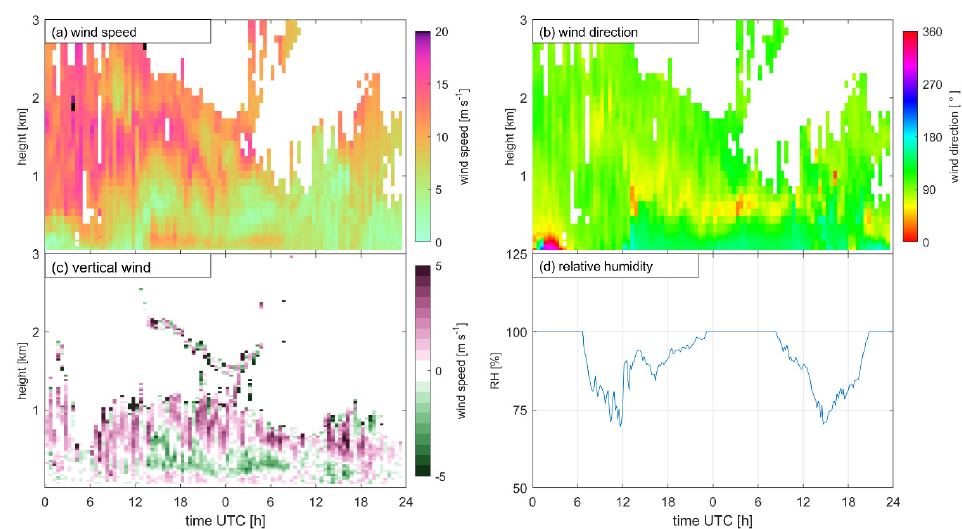
Figure 12. Wind speed ( a , [m s − 1 ]), wind direction ( b , [°]), vertical wind velocity ( c , [m s − 1 ]), relative humidity ( d , [%]) on 31 July and 1 August, 2019, at KEF. The wind velocities are retrieved from lidar VAD scan. The relative humidity is measured at the weather station at Keflavik International airport. The time axis starts from 00:00 UTC, 31 July, 2019.